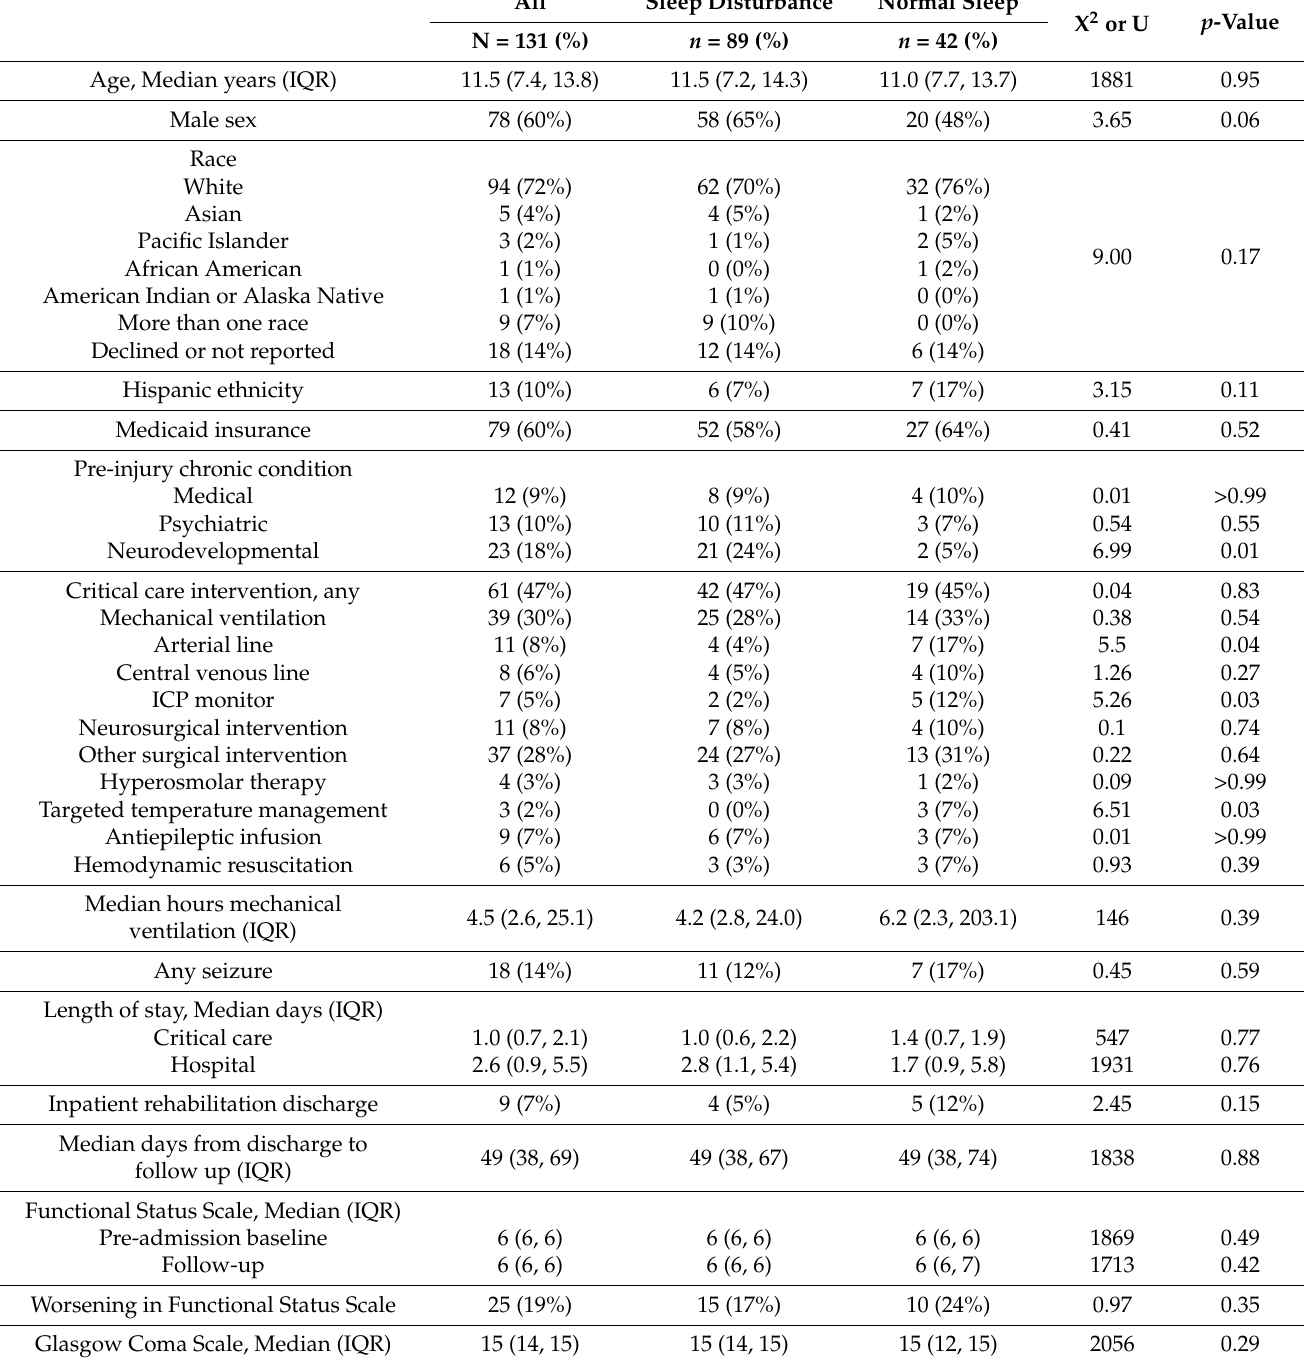
Table 1. Demographic and clinical characteristics of the overall cohort and by sleep disturbance group. All Sleep